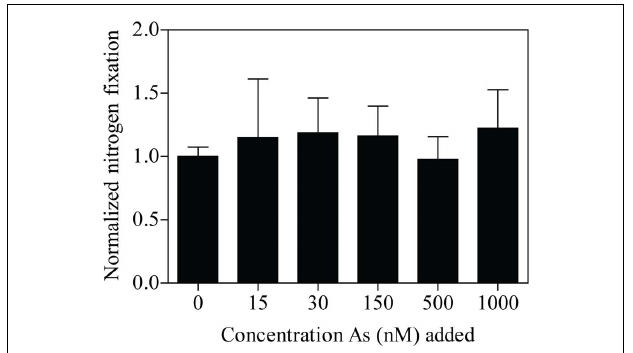
FIGURE 6 | Expression patterns for arsB and pstS in cultures transferred into either phosphate replete ( + P) or no added P ( − P) medium. The expression ratio is the fold change of triplicate measurements between the sample expression and the calibrator expression (e.g., the zero time point). Error bars indicate the SE of triplicate measurements of the expression ratio. Significance ( p < 0.05) is indicated (*) for the − P versus the + P culture at a single time point for pair-wise fixed reallocation randomization analysis.